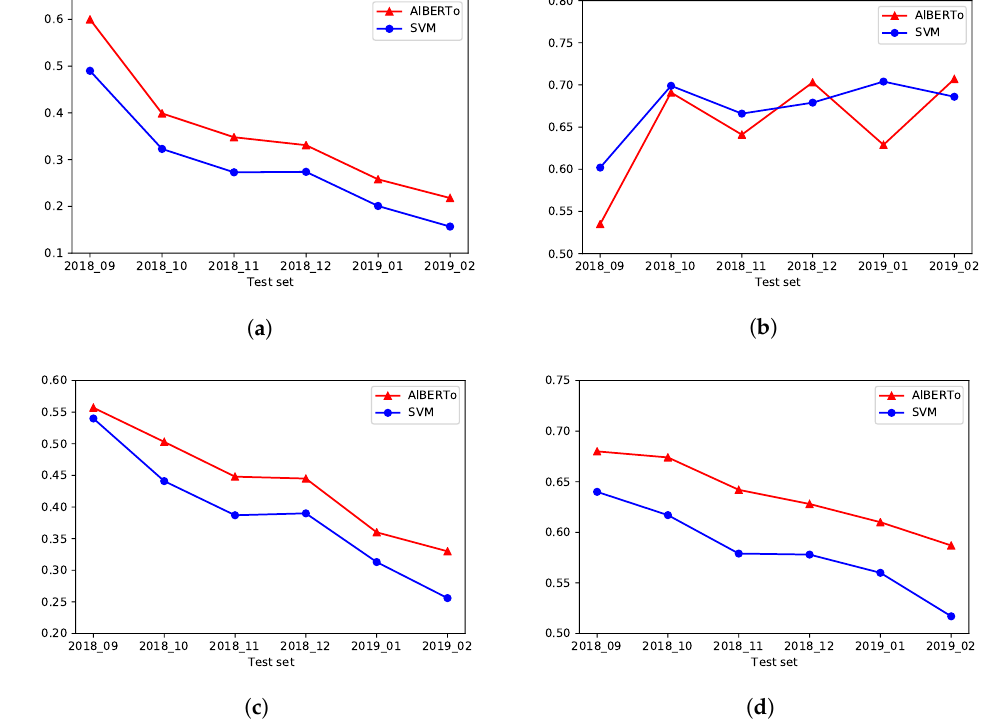
Figure 2. Evaluation of the model trained on Haspeede+ (fixed training set). ( a ) Precision on the positive class. ( b ) Recall on the positive class. ( c ) F1-score on the positive class. ( d ) Macro-averaged